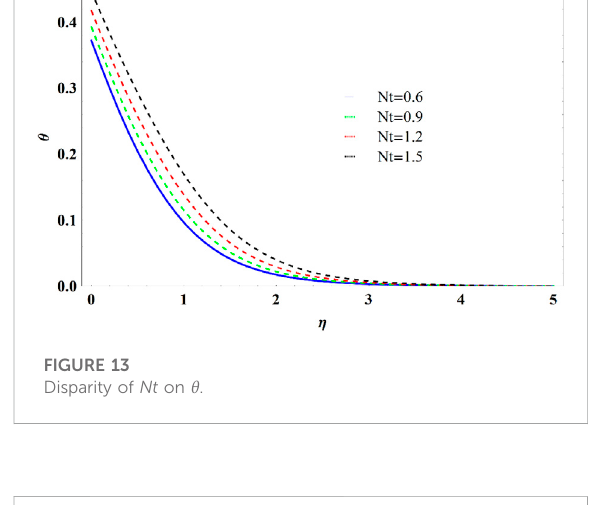
FIGURE 13 Disparity of Nt on θ .